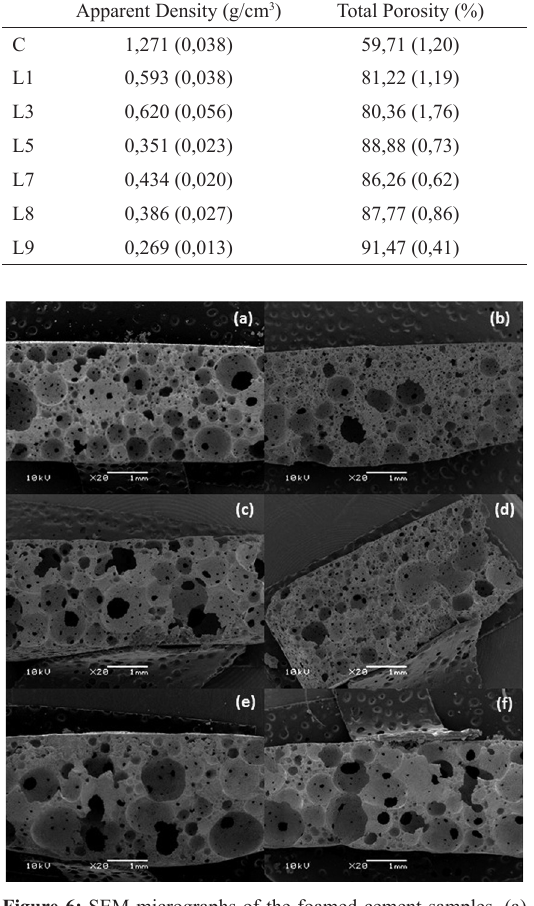
Figure 6: SEM micrographs of the foamed cement samples. (a) L1; (b) L3; (c) L5; (d) L7; (e) L8; (f) L9.